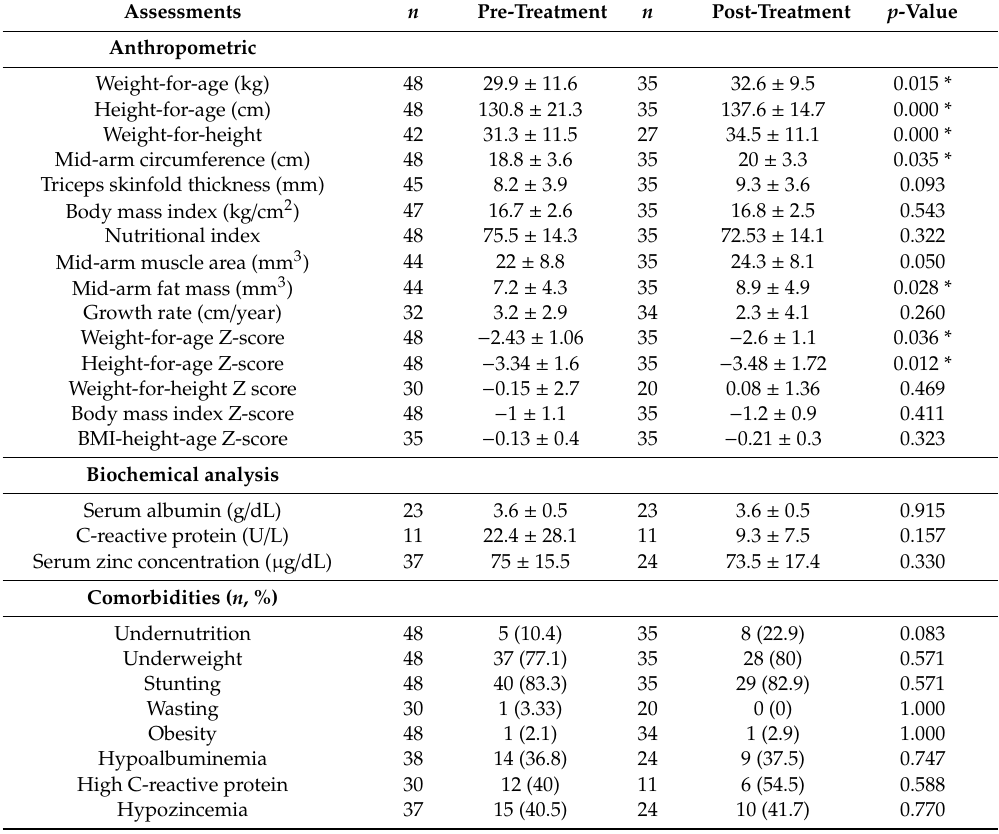
Table 3. Di ff erences between assessments pre and post zinc supplementation in the whole series ( n =